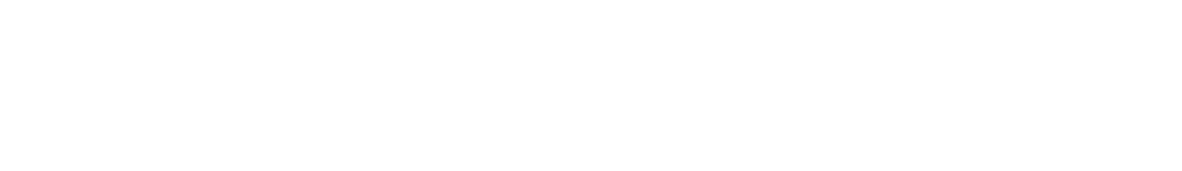
Frontiers in Earth Science |